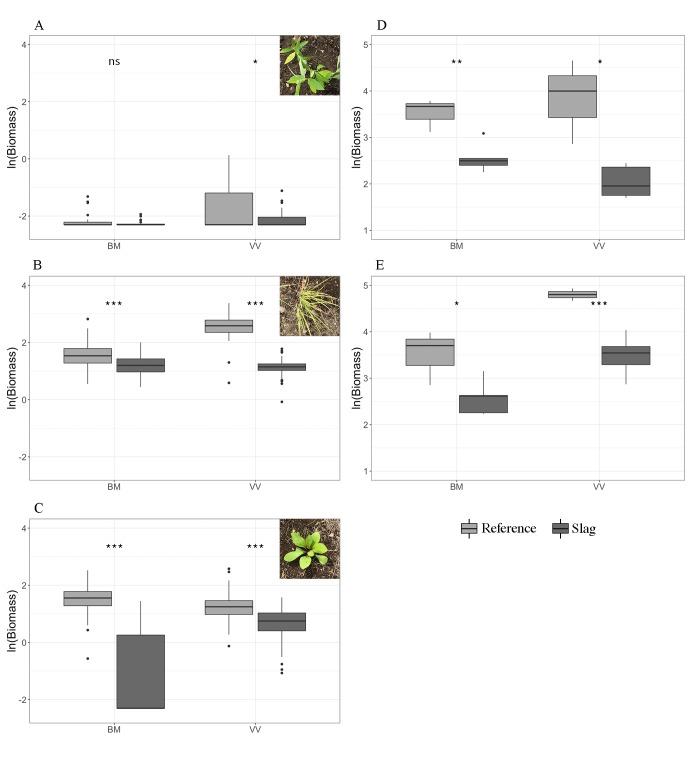
Comparison between locales and sites of final harvested biomass, in grams, from all types of experimental plots.(A) Focal species Asclepias syriaca. (B) Focal species Bouteloua curtipendula. (C) Focal species Solidago speciosa. (D) Removal plots. (E) Topsoil plots. All y axes are ln(biomass + 0.1) in g, x axes are locales. Significance levels: p > 0.05 (ns), p < 0.05 (*), 0.01 < p < 0.05 (**), p < 0.001 (***). See Table F in S1 File for complete statistics. All photos were taken by the authors.